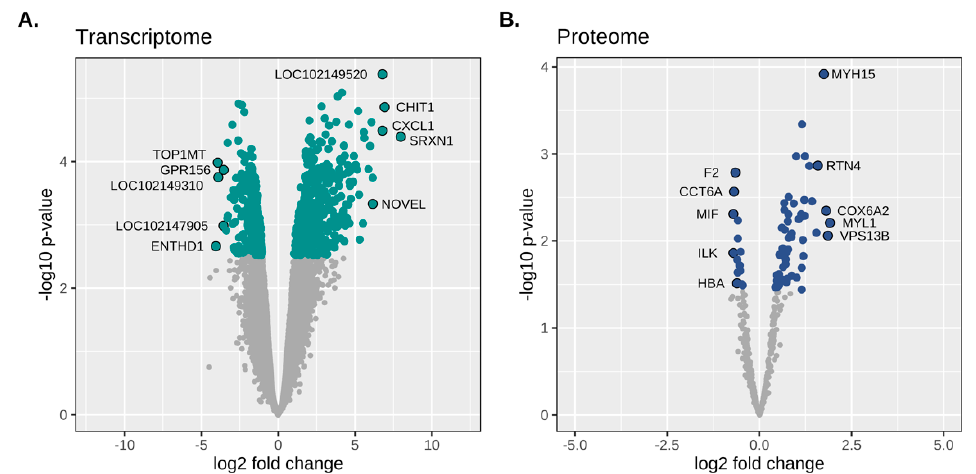
Figure 2. Transcriptomic and proteomic differential expression in RER-susceptible Standardbreds. ( A ). Volcano plot depicting the probability of observing the estimated change in gene expression ( − log 10 scale) on the Y axis and the degree of fold change differences (log 2 scale) on the X axis. ( B ). Volcano plot depicting estimated p -values from differential expression of protein analysis versus log 2 fold change. There were 791 differentially expressed genes (green dots; FDR ≤ 0.05) and 62 differentially expressed proteins (blue dots; FDR ≤ 0.10) between RER-susceptible and control horses. The genes/proteins with the highest and lowest fold changes are annotated on each graph.